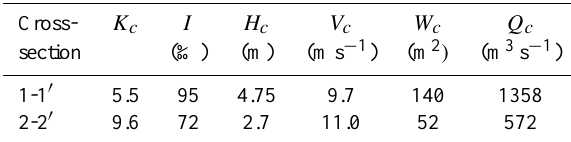
Fig. 15. Breaching of the debris-dams that partially blocked the river, raising the riverbed. After five days, an artificial spillway was completed to successfully release the impounded water.